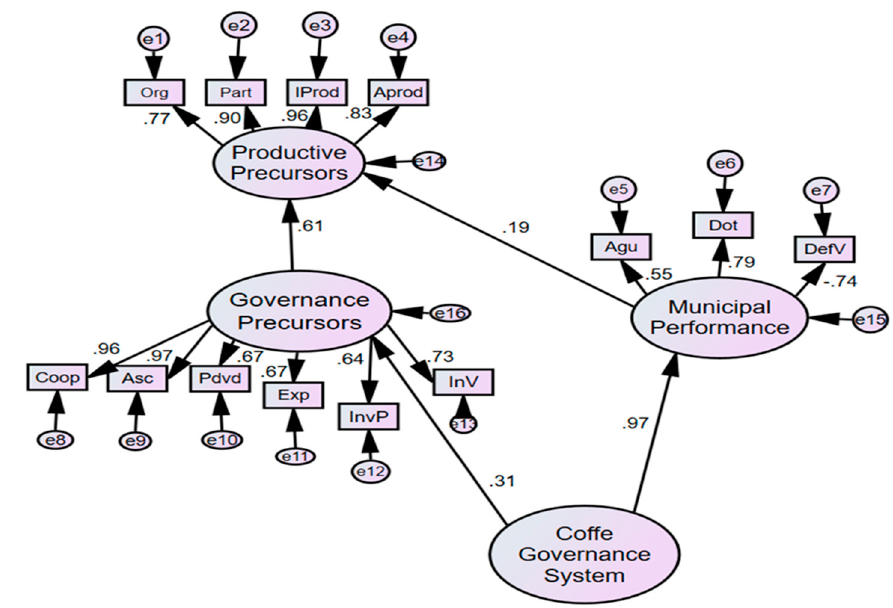
Figure 3. SEM Analysis Coffee Governance Model.